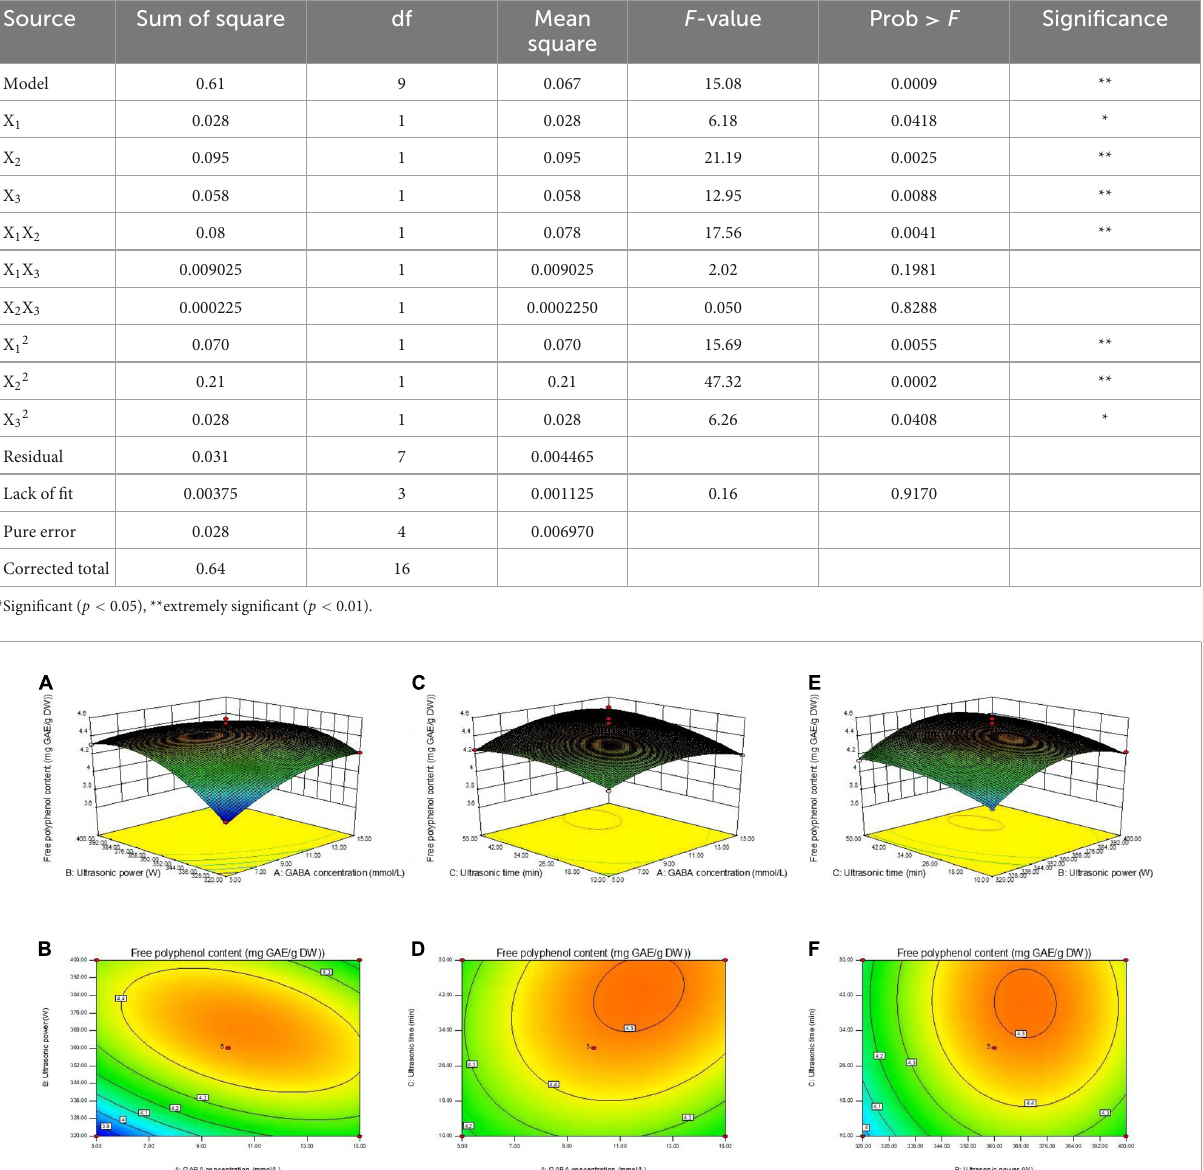
TABLE 3 Analysis of variance (ANOVA) of response surface regression model.